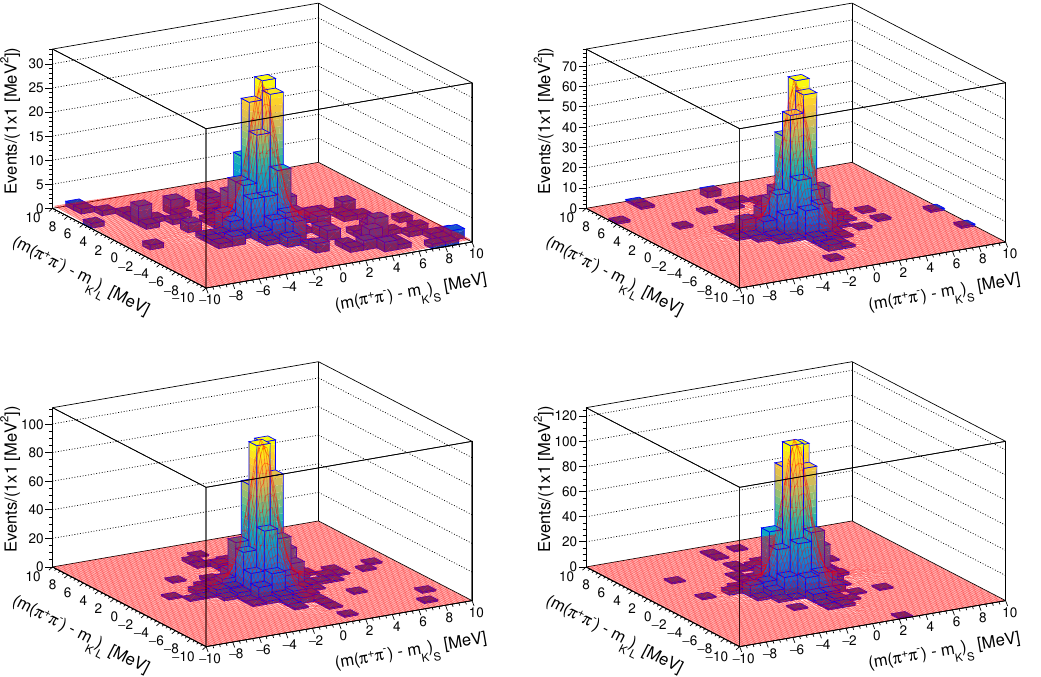
Figure 1 . Invariant mass distribution of K L vs. K S vertices for four ∆ t bins: 0 < ∆ t < 1 τ S (top left), 1 < ∆ t < 2 τ (top right), 2 < ∆ t < 3 τ (bottom left), and 3 < ∆ t < 4 τ (bottom right). S S S The histograms of data have superimposed the result of the unbinned fit (red). factors for signal and background, respectively. The background events are then extrapo- lated from the | x, y | < 10 MeV region to the nominal signal region | x, y | < 5 MeV. The result is n = 39 ± 5 events for the first bin ( 0 ≤ ∆ t < 1 τ ). The consistency of this result B, 1 S